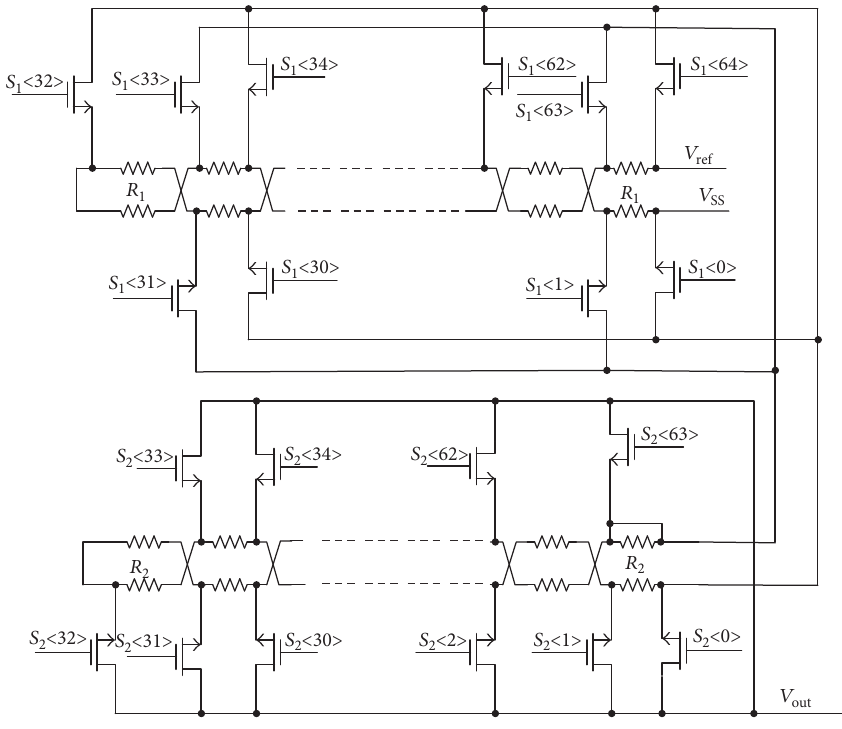
Figure 6: Dual ladder resistor string